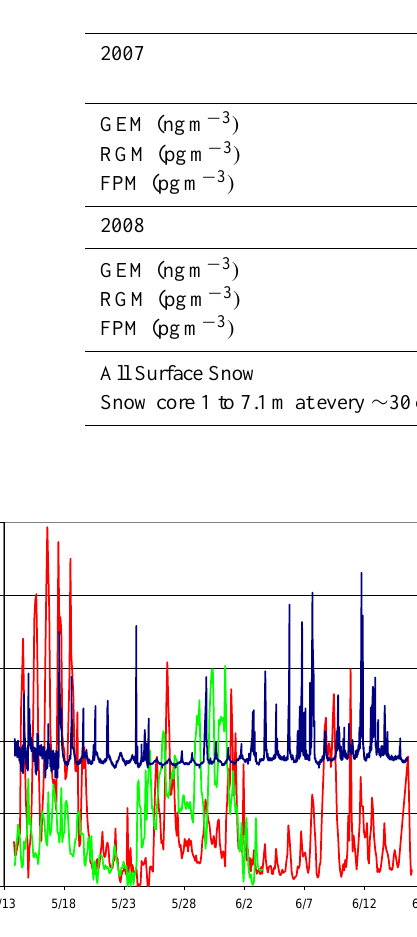
Fig. 2. All atmospheric mercury speciation data from the 2008 cam-